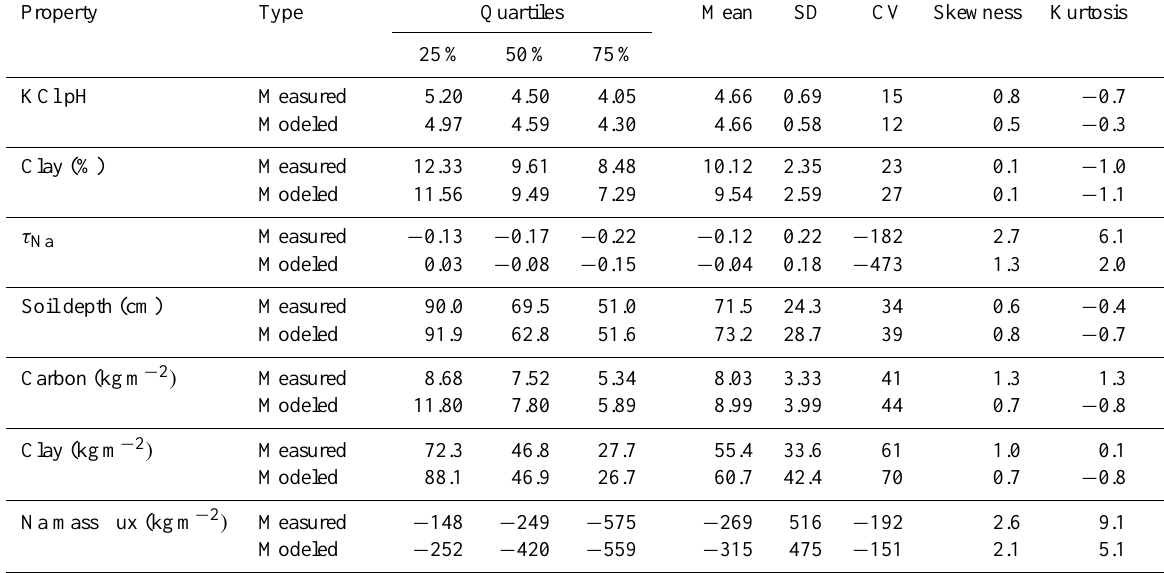
Table 8. Comparison of measured and modeled soil property summary statistics.